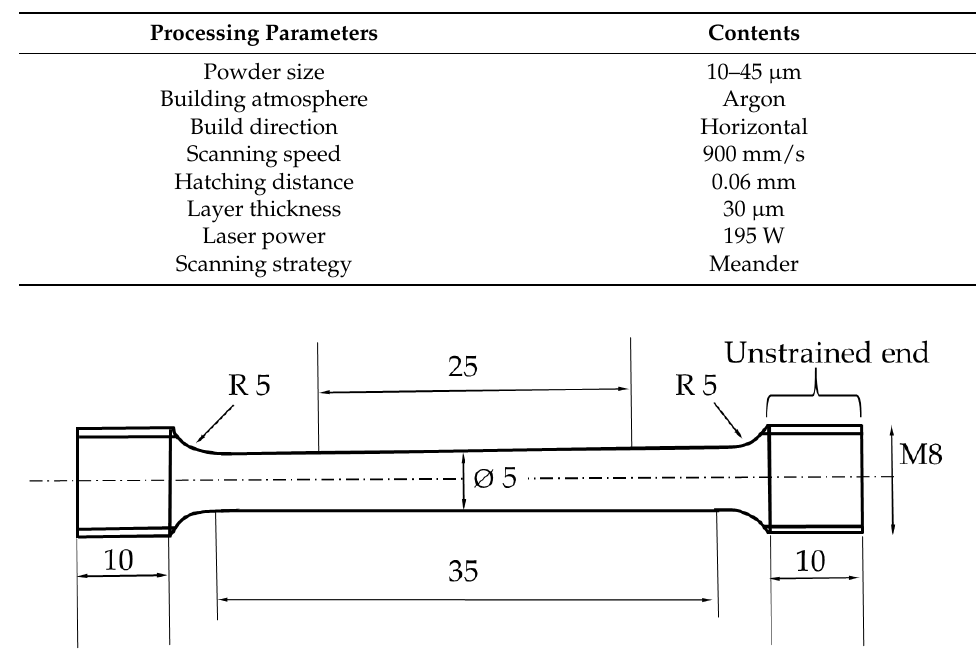
Figure 1. Drawing of the specimen design according to ISO 6892-1. Dimensions in